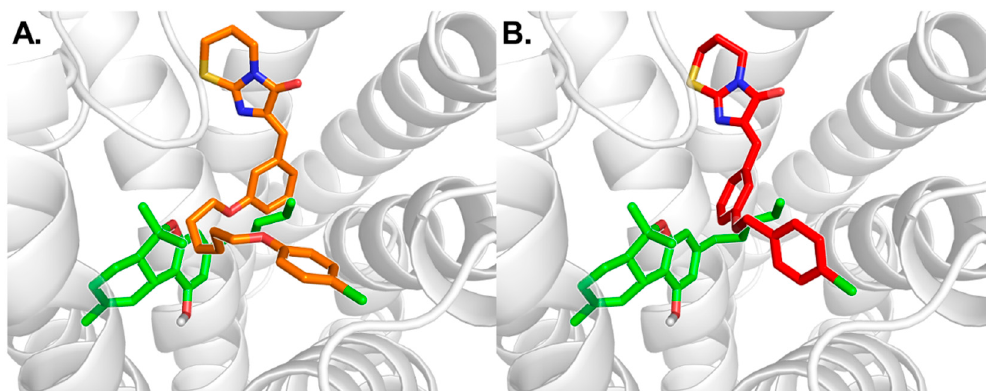
Figure 9. ( A ) Comparison of the proposed binding mode of THC (green) and antagonist 4 (orange) at human GPR18. ( B ) Comparison of the proposed binding modes of THC and antagonist 5 (red).